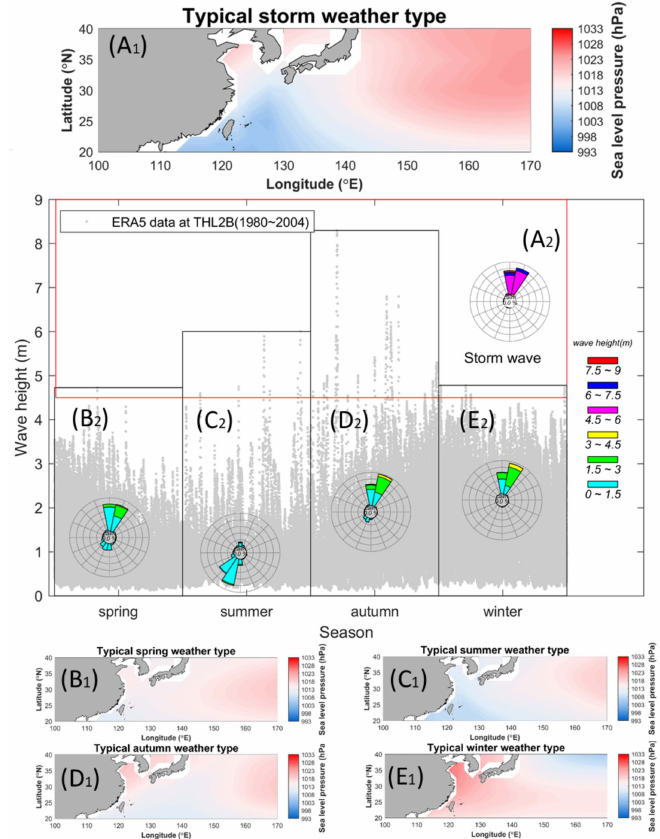
Figure 7. Relationship between the representative atmospheric patterns corresponding to the wave conditions at the THL2B site. (Different weather types are ( A ) storm, ( B ) spring, ( C ) summer, ( D ) autumn and ( E ) winter. Subscripts are ( 1 ) weather type pattern and ( 2 ) corresponded wave rose diagram).